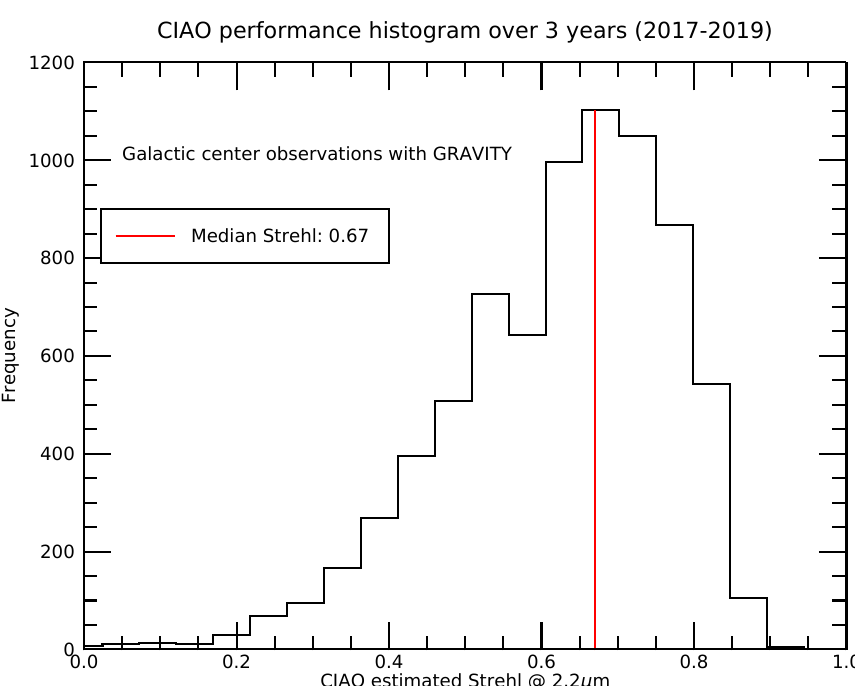
Figure 8. CIAO Strehl histogram for 3 years of GC observations with